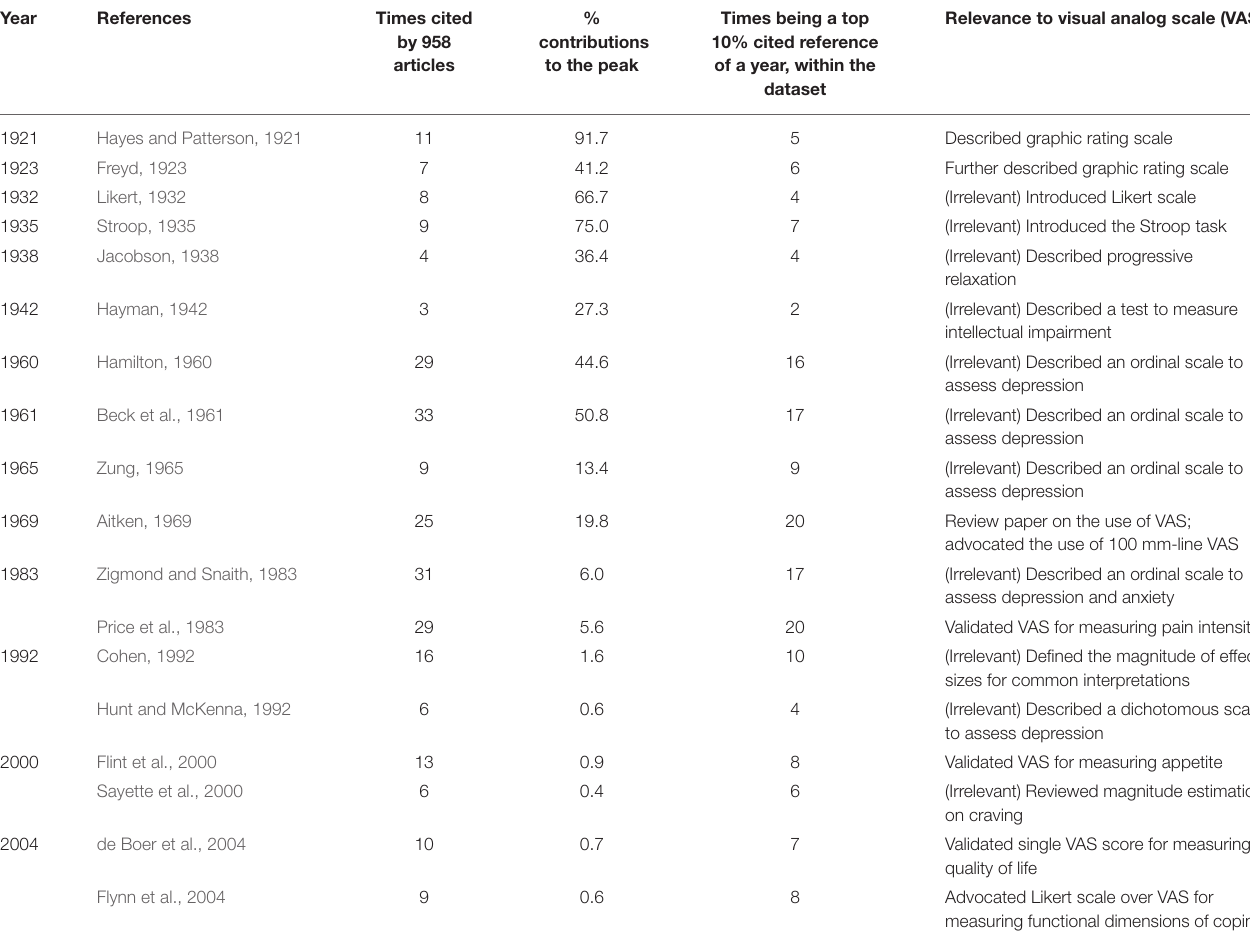
TABLE 1 | Seminal references identified by reference publication year spectroscopy